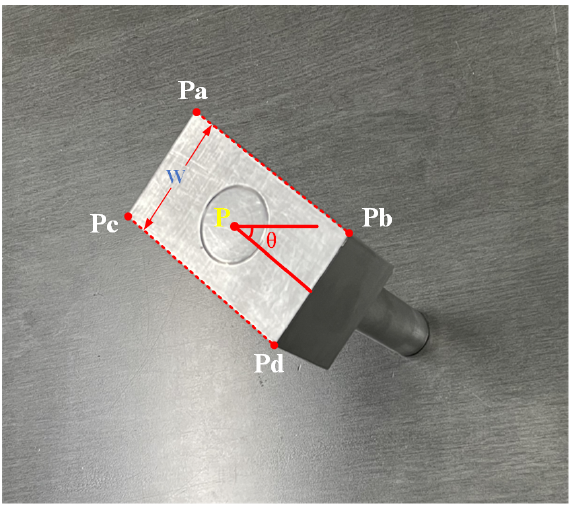
Figure 4. The elements contained within the grasping